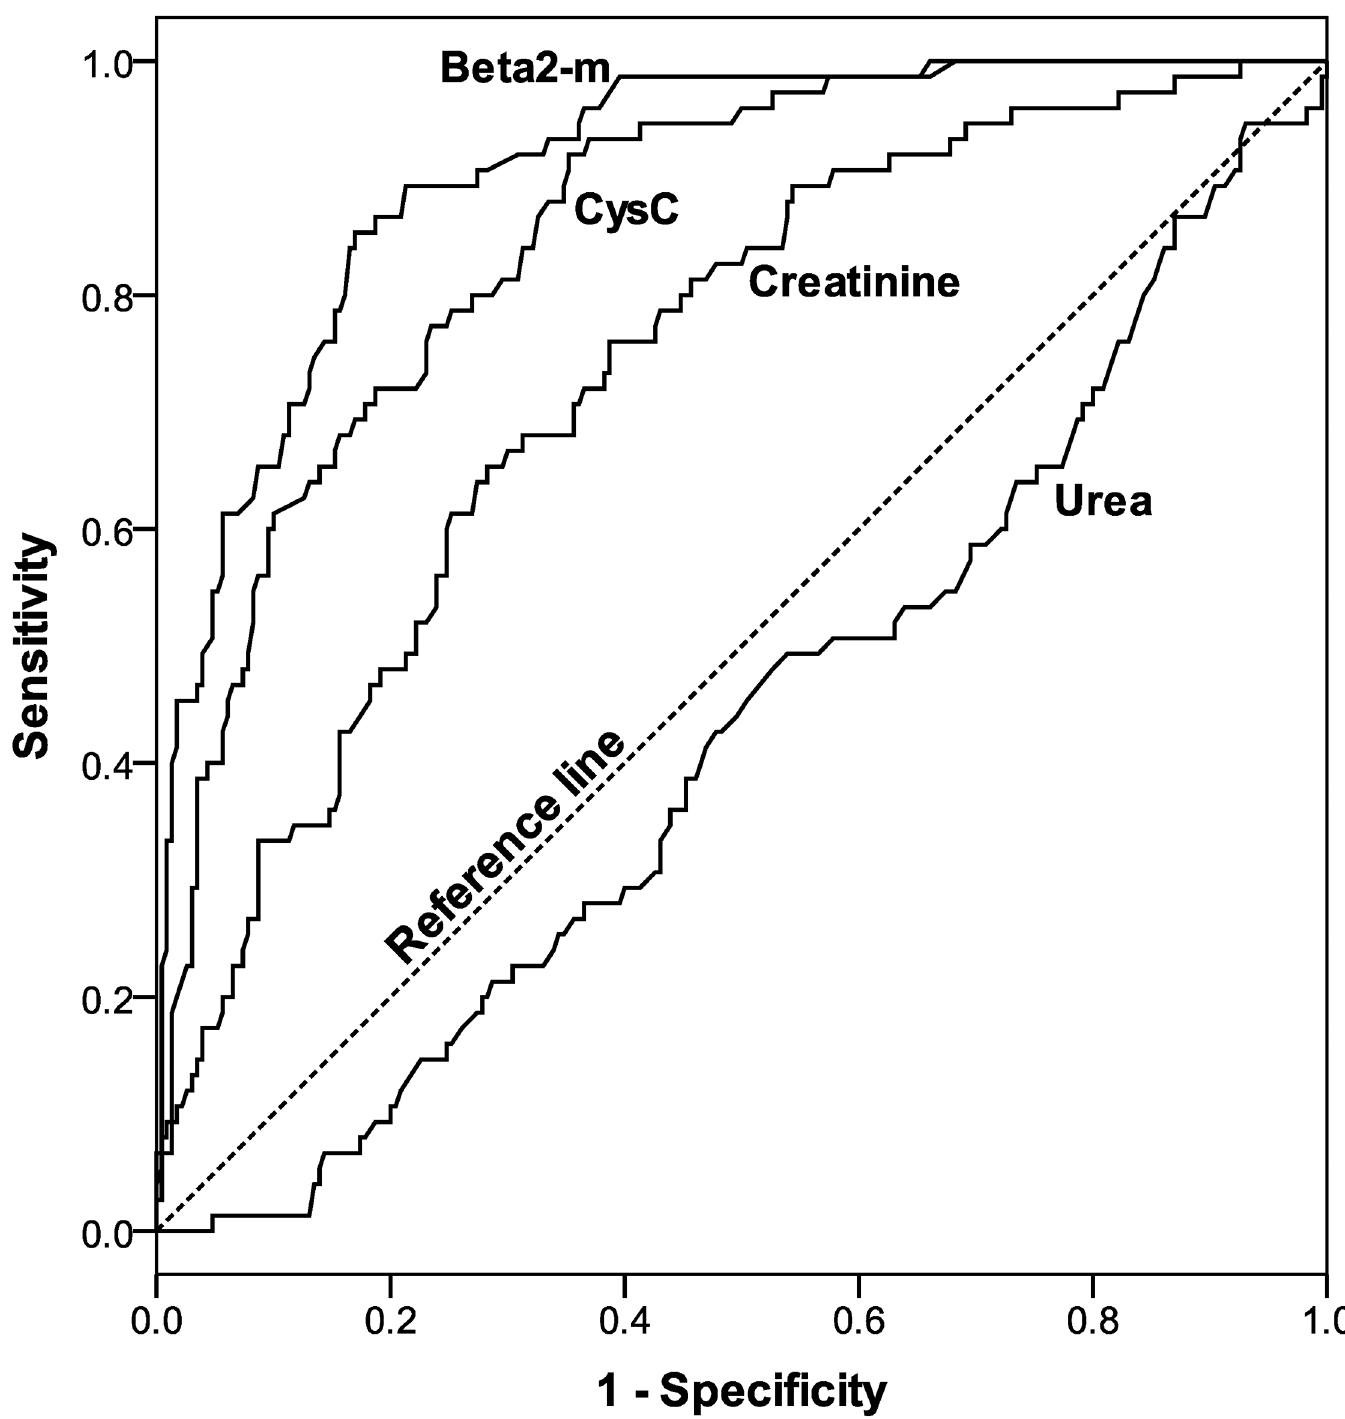
Fig 3. ROC analysis of pre-dialysis levels of Cystatin C, β 2-microglobulin, urea and Cystatin C to identify patients with significant residual renal urea clearance (cid:4) 2ml/min/1.73m 2 BSA. The greatest area under the curve was for β 2-microglobulin.